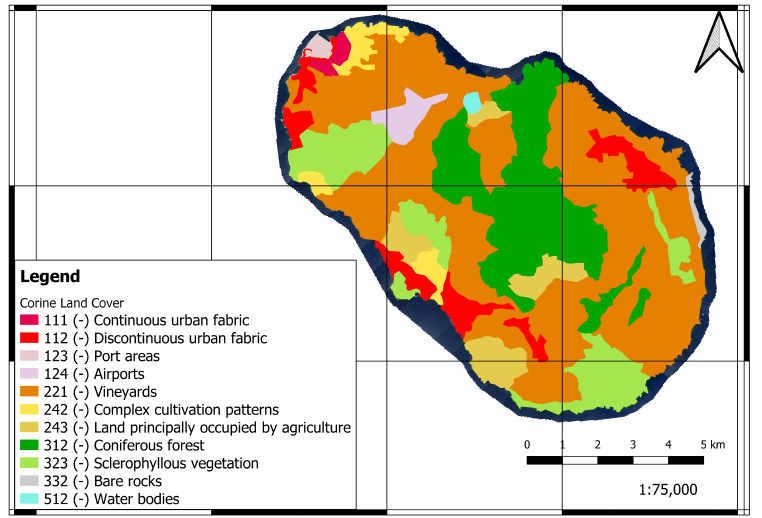
Figure 7. Pantelleria land cover